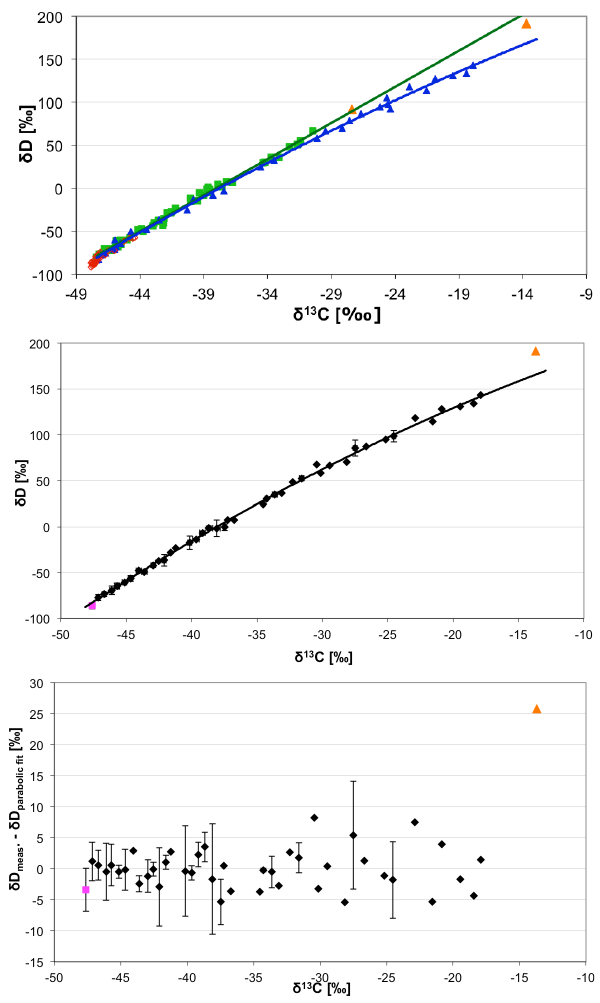
Figure 3: Isotope-isotope correlation (a) for tropical (red) mid-latitude (green) and polar (blue) samples, exceptional samples from KIR-03-03 ( ◊ ) in orange. Mid-latitude samples follow a linear fit, whereas polar samples follow a parabolic fit. The parabolic shape dominates in the fit to all data (b) . Here, the data was binned in 0.5‰ δ 13 C intervals to reduce the statistical weight of the more abundant higher mixing ratio (lower δ -values) samples. The residu- als between parabolic fit and data (c) , excluding the highest enrich- ment point, show no systematic structure. The error bars represent typical variations in a 0.5‰ δ 13 C